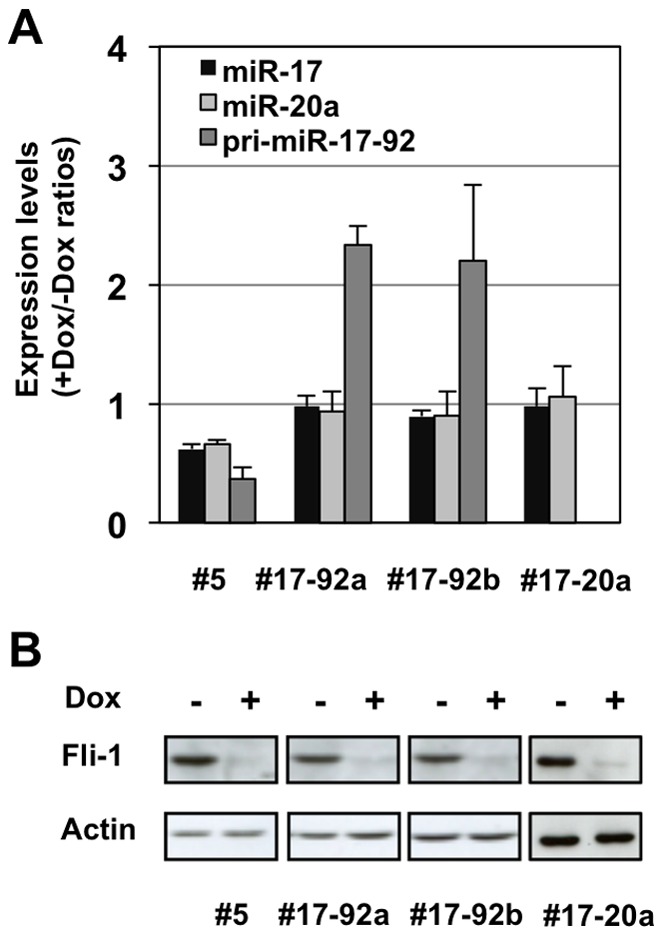
Restoration of initial levels of miR-17 and miR-20a following Dox-induced Fli-1 knockdown in NN10#5 cells.#17-92a, #17-92b or #17-20 cell clones have been derived from parental NN10#5 cells following stable transfection of a Dox-inducible expression cassettes of the whole miR-17-92 cluster or only miR-17-20a sub-cluster, respectively. A: Parental NN10#5 cells and their derivative clones #17-92a, #17-92b or #17-20 harboring inducible exogenous whole miR-17-92 miRNA cluster or miR-17-20a sub-cluster were cultured for two days in the presence or absence of Dox and the relative levels of pri-miR-17-92, miR-17 and miR-20a levels were determined by qRT-PCR as in Figure 4. Results are expressed as +Dox/-Dox ratios (means and standard deviations from 3 independent experiments). B: Fli-1 expression analysis by western blot in indicated cell clones after two days in presence or absence of Dox using β-actin signal as a loading control.